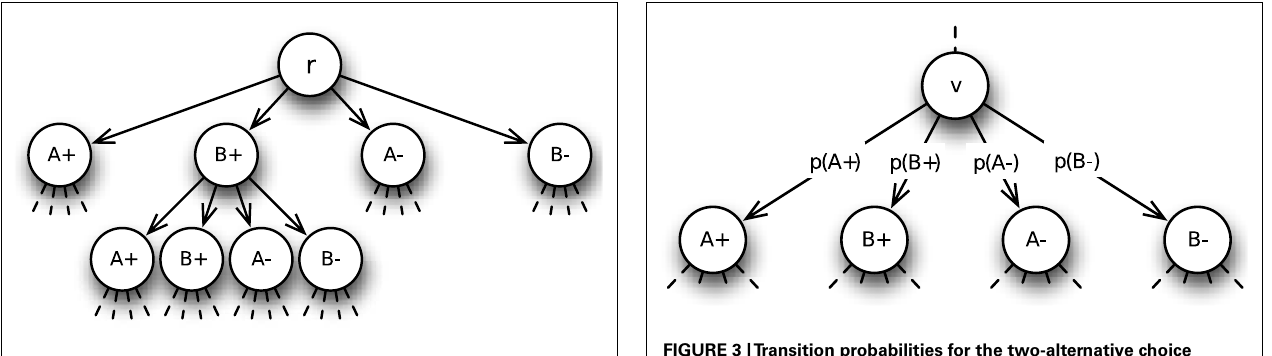
FIGURE 1 | 4-ary tree for choice between two alternatives A and B . The root r has four outgoing edges directing to four vertices that represent the counters A + , A − , B + , and B − . Each of these vertices has four outgoing edges and thus four children itself, and so forth.